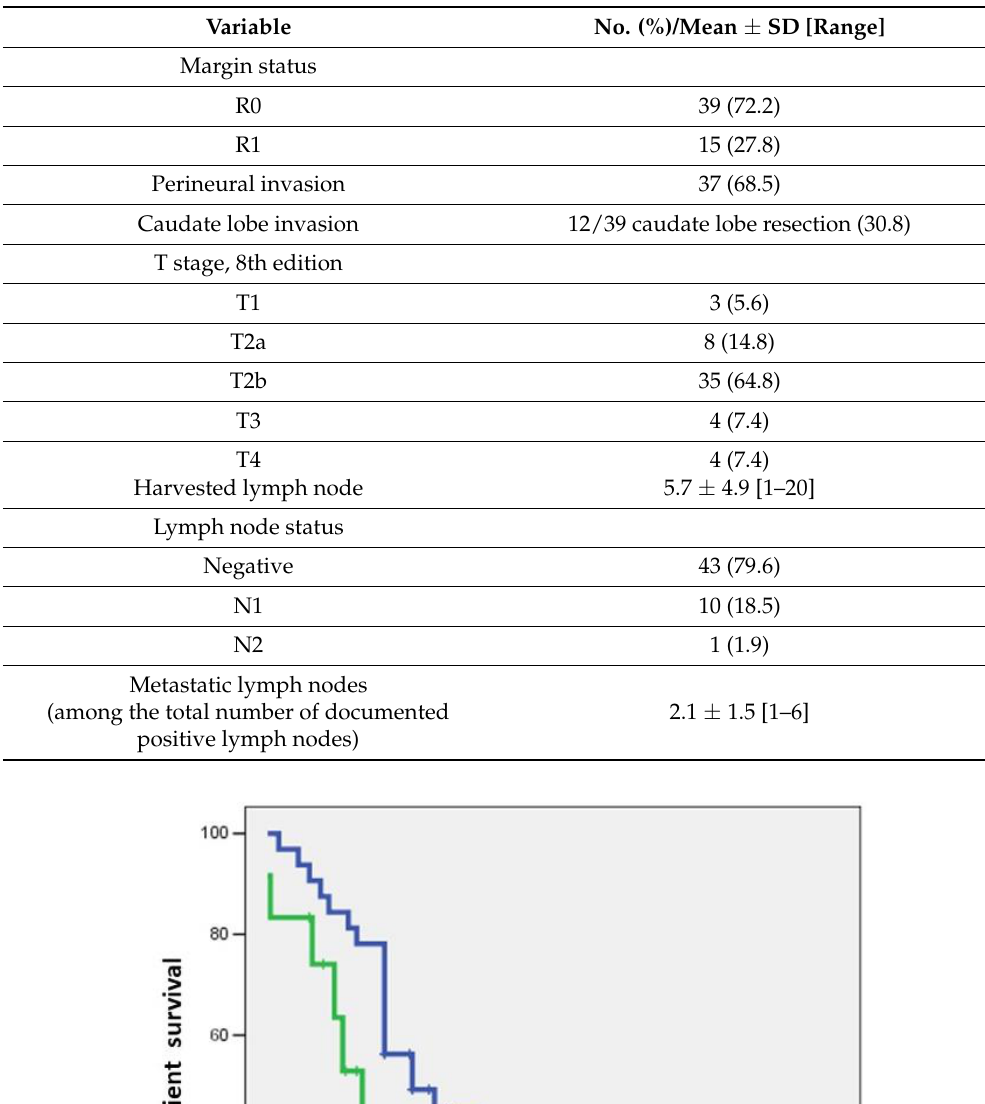
Table 4. KRAS mutation analysis .